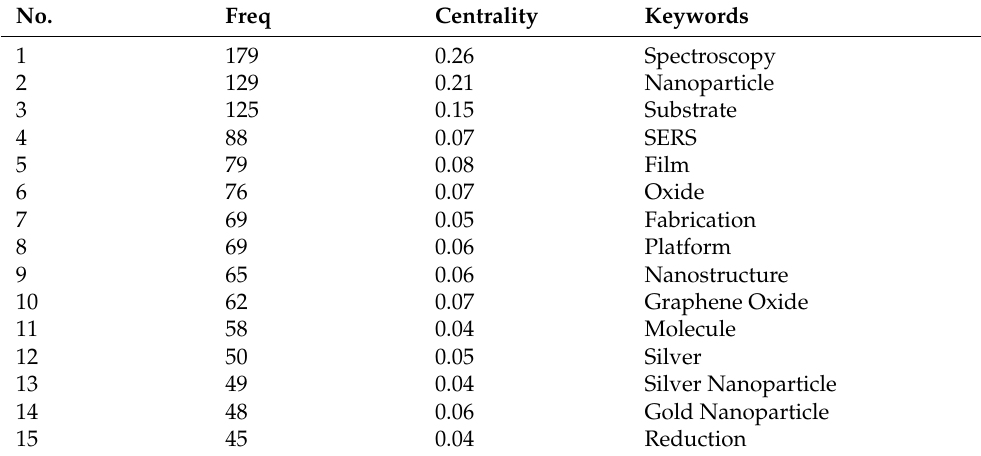
Table 4. A list of the top 15 keywords for graphene-based SERS. No.